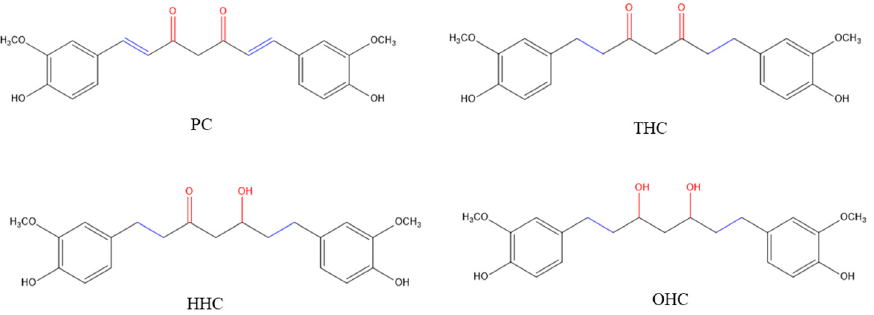
Figure 1. Chemical structures of the parent compound, curcumin (PC) and its hydrogenated metab- olites (HMs): Tetrahydrocurcumin (THC), Hexahydrocurcumin (HHC) and Octahydrocurcumin